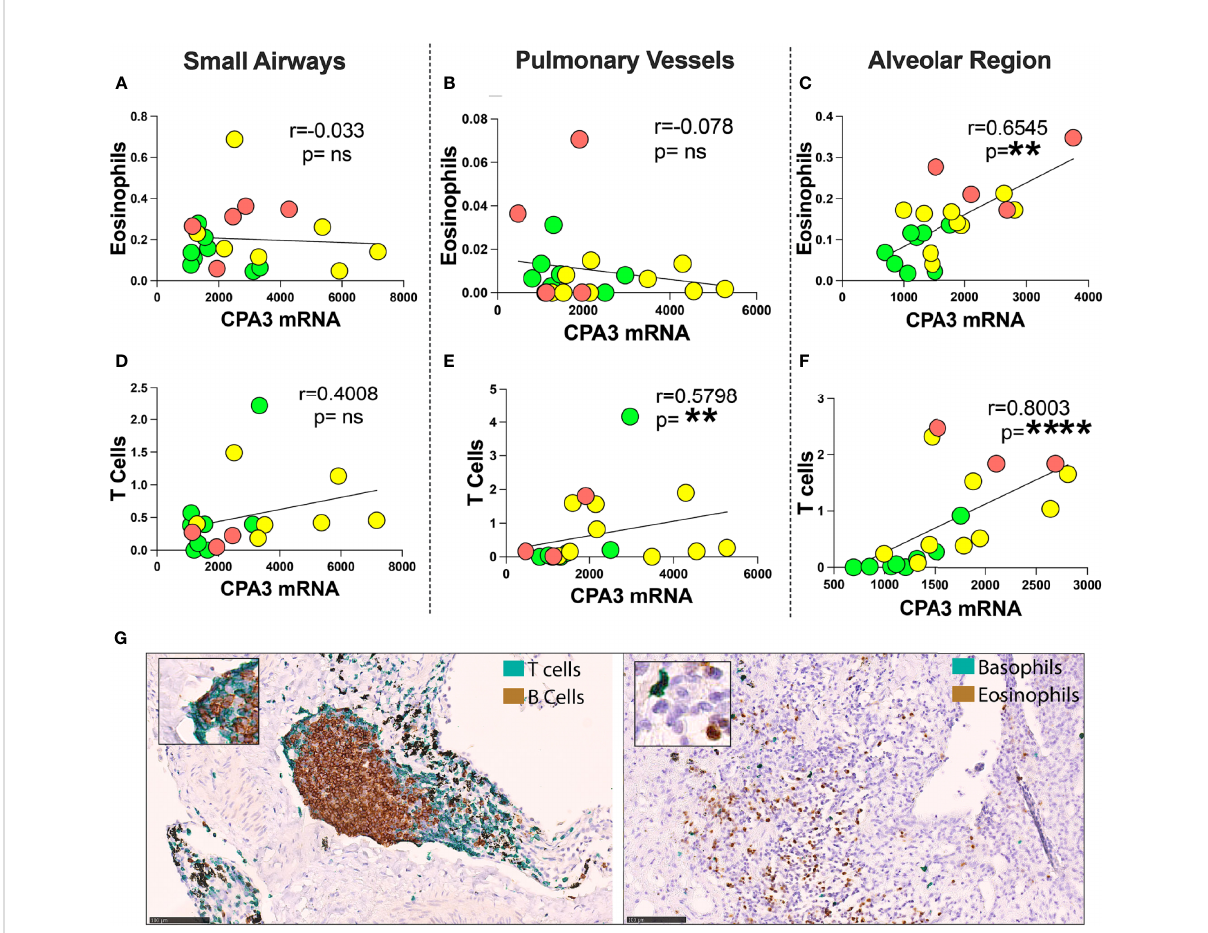
FIGURE 7 Correlation between mean mast cell CPA3 mRNA and eosinophils and CD3+ T lymphocytes. (A – F) Scattergrams with pooled mean patient data (green circles = healthy controls, yellow = COD, and red = IPF). Correlation analysis was performed with the non-parametric Spearman´s pairwise correlation test. r = correlation coef fi cient, the p -values and signi fi cance levels are shown as ** p < 0.01 and **** p < 0.0001. (G) Bright- fi eld micrographs exemplifying CD3+ T lymphocyte and CD20-positive B lymphocyte double staining (left) and basophil and eosinophil double staining (right) with brown (DAB chromogen) and green (Vina green chromogen). Scale bars = 100 m m. ns, non-signi fi